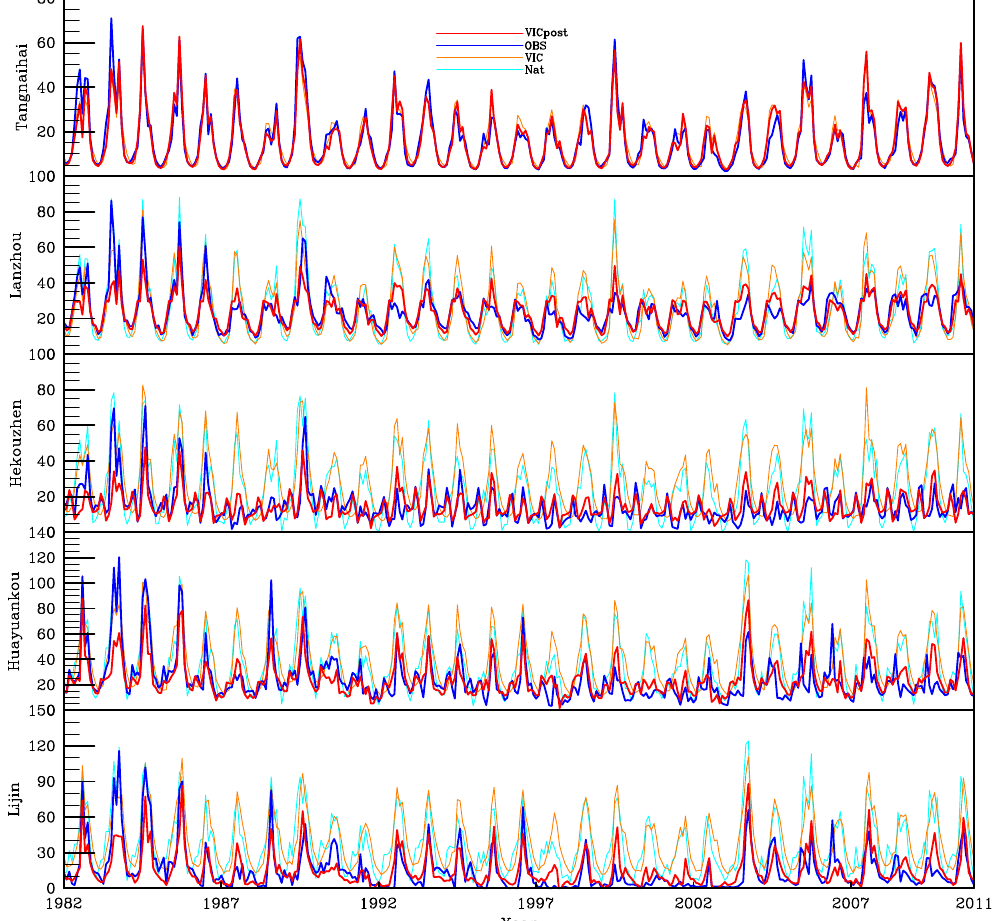
Figure 7. Naturalized (cyan) and observed (blue) monthly streamflow (10 8 m 3 s − 1 ), and VIC-simulated monthly streamflow (10 8 m 3 s − 1 ) before (orange) and after (red) the post-processing at five hydrological gauges located from upper to lower mainstream of the Yellow River. During the post-processing procedure, the simulated streamflow without human interventions is linearly regressed against the observed streamflow for each target